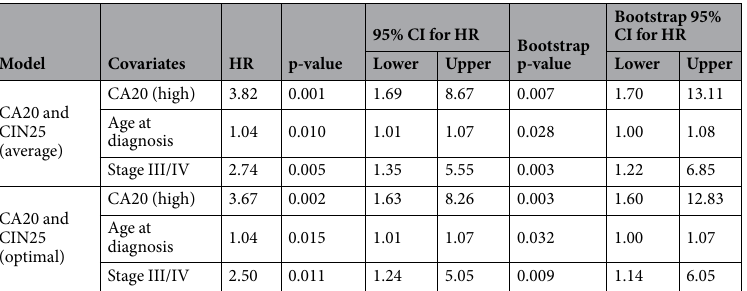
Table 6. Final multivariable Cox proportional-hazards models of overall survival including CA20 and CIN25 (based on average or optimal thresholds), AJCC stage, and age at diagnosis in full models using TCGA data along with p-values and 95% confidence intervals (CIs) for final model covariate hazard ratios obtained via simple bootstrapping. References for hazard ratios (HRs) are CA20 (low) and stage